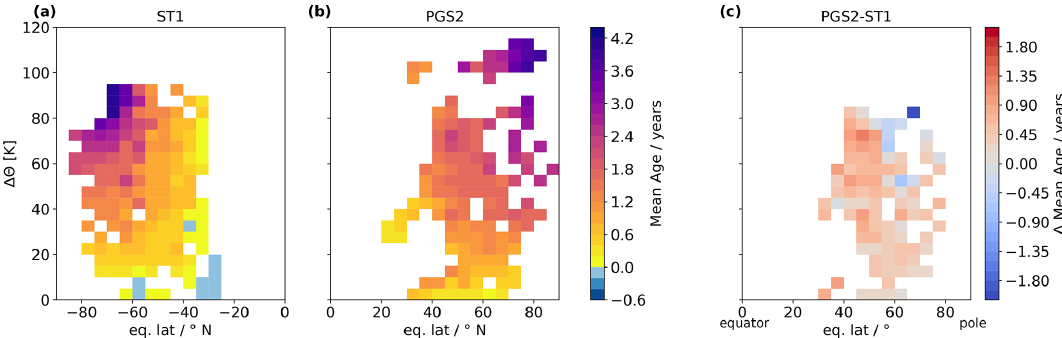
Figure 4. Comparison of mean age latitude–altitude distributions during SouthTRAC phase 1 (ST1) (a) , PGS phase 2 (PGS2) (b) . The hemispheric difference based on these two campaign phases is shown in panel (c) . Altitude is given in (cid:49)θ . Horizontally, data are sorted by eq.